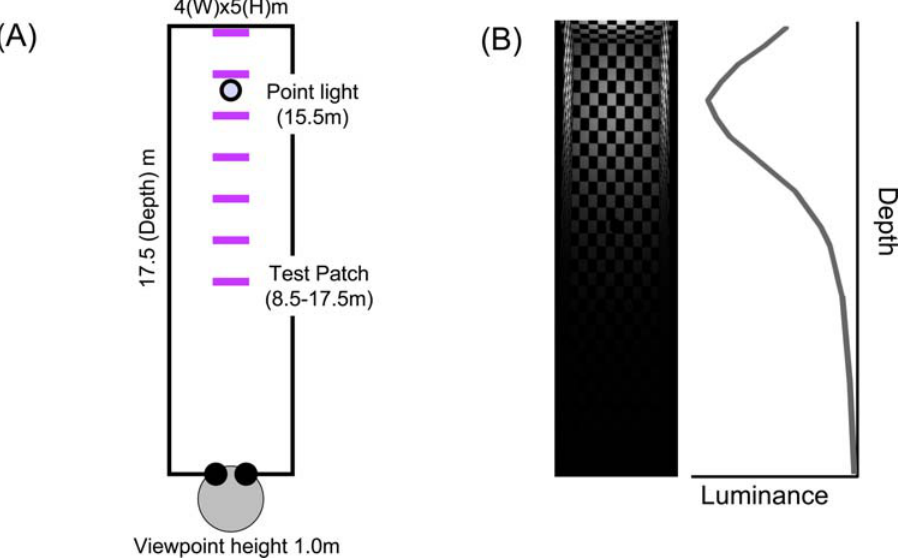
Figure 3. The rendered scene. (A). Top view of the rendered scene. The test patch (violet) could be at any of seven depths. (B). A plot of the actual intensity of light incident on the test patch as a function of depth, and a top view of rendered room.